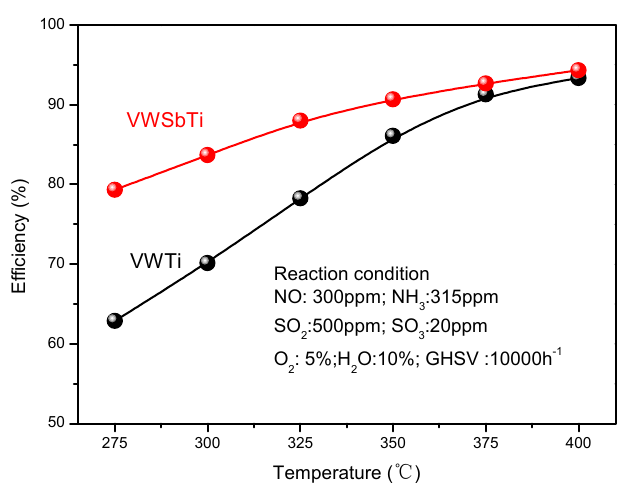
Figure 1. DeNO x performance of catalysts at different temperatures.